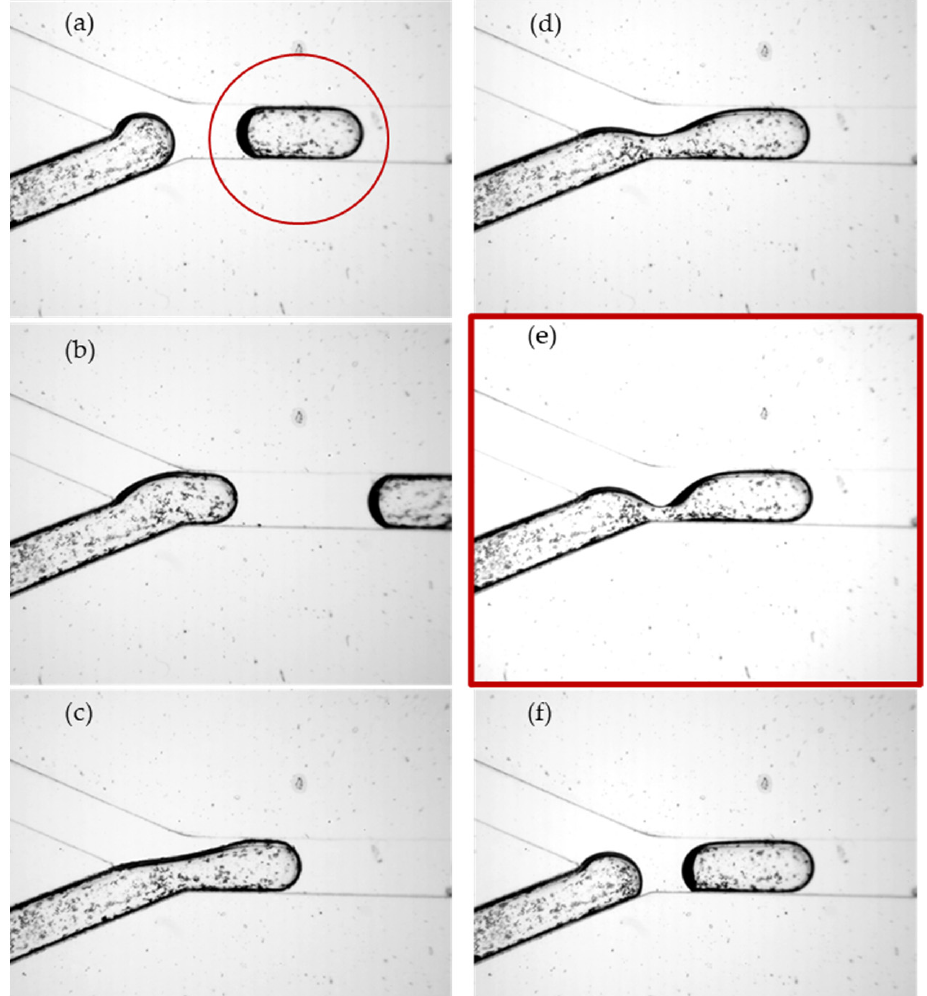
Figure 6. Interface dynamics and water-droplet formation in oil for one cycle; series of images captured from video recordings at 1000 fps: from droplet detachment ( f , a ) to the interface rupture ( e ). ( a ) previous droplet marked in red circle; ( b ) water advancement; ( c ) neck formation; ( d ) neck thinning; ( e ) neck before interface rupture; ( f ) droplet after interface rupture.